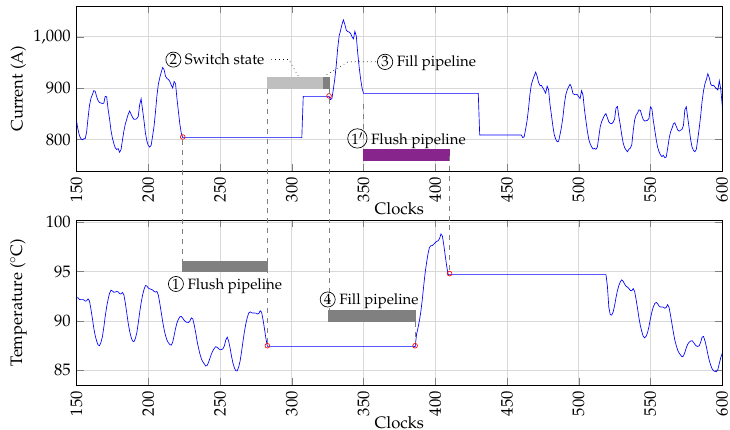
Figure 22. Behavior of the thermal model pipeline during a grid state change causing a load increase.